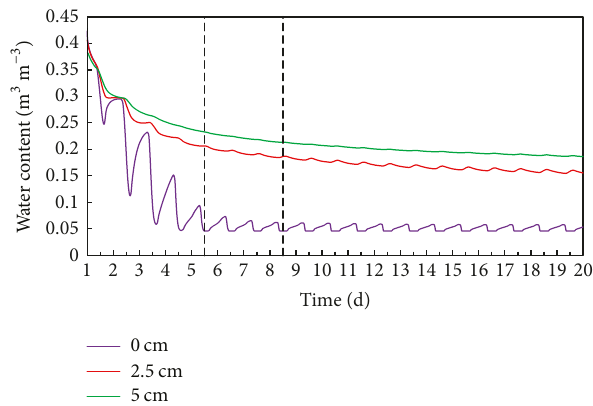
Figure 4: Simulated temporal variations of soil water contents at depths of 0, 2.5, and 5 cm during the soil drying after a rainfall event.